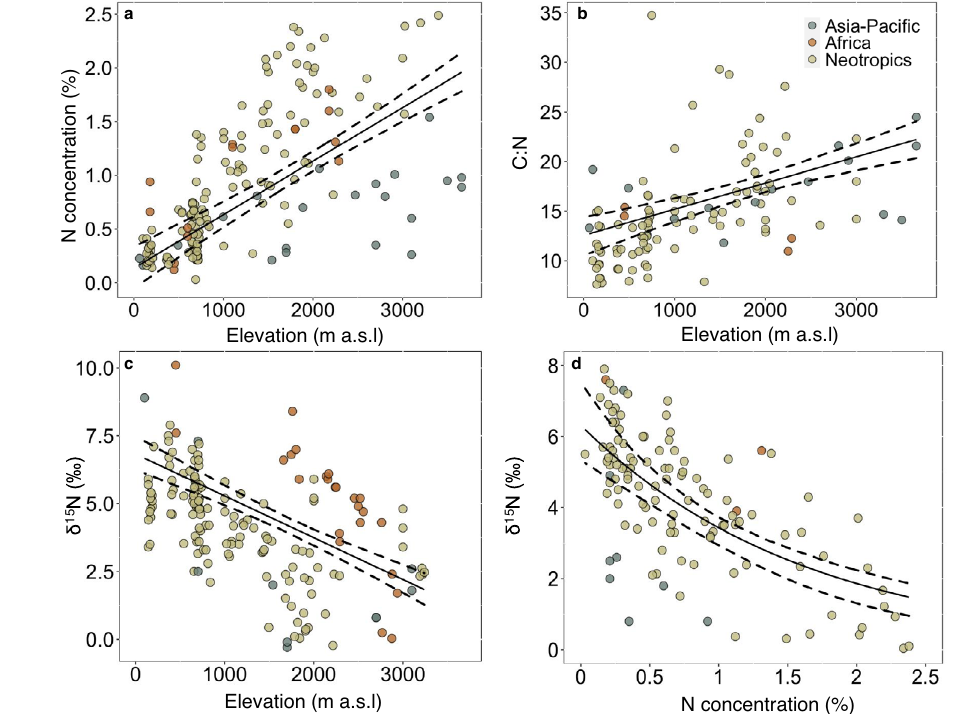
Fig. 2 | Elevational distribution of soil N concentration, C:N ratios, and δ 15 N acrosstropicalmontaneforests. ThechangeinsoilNconcentrations( a ),C:N( b ), and δ 15 N ( c ) with increasing elevation were determined using linear mixed-effect modelswithelevationasthe fi xedeffectandtransectidentitynestedwithintropical region as a random effect (Supplementary Table 2). d negative exponential